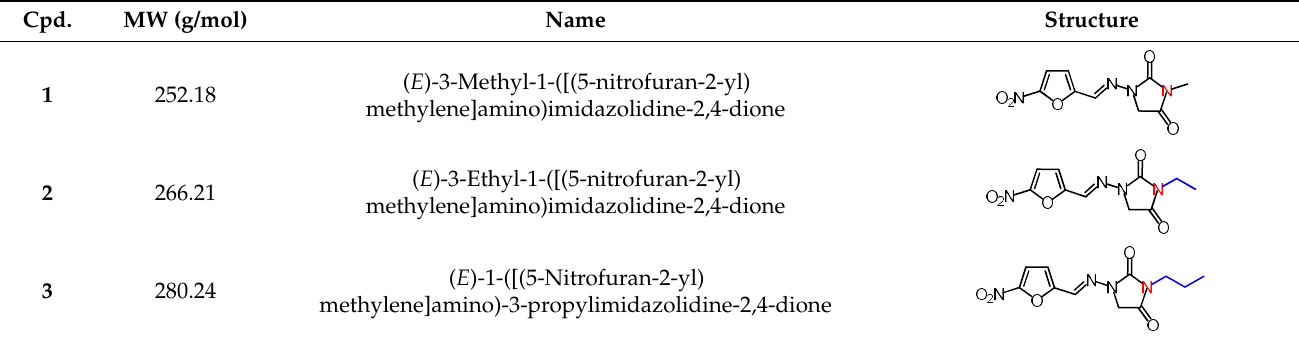
Table 1. Structures of synthesized nitrofurantoin analogues 1 – 19 .